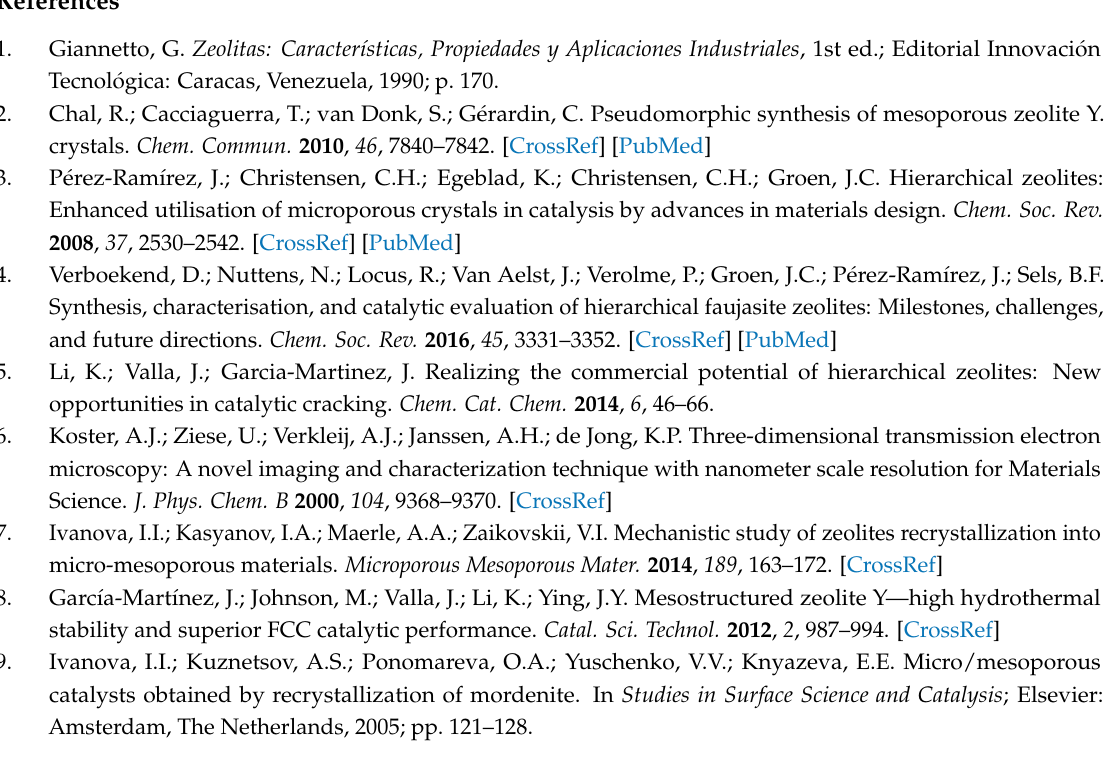
Figure S1: X-ray diffractograms of the sample YB0.08-S0, Figure S2: Nitrogen adsorption (closed symbols) and desorption (open desorption) isotherms at 77 K of the modified samples produced using different concentrations surfactant, Figure S3: Nitrogen adsorption (closed symbols) and desorption (open desorption) isotherms at 77 K of the modified samples produced using different concentrations of the alkaline medium, Figure S4: Thermogravimetric analysis of the sample original USY and